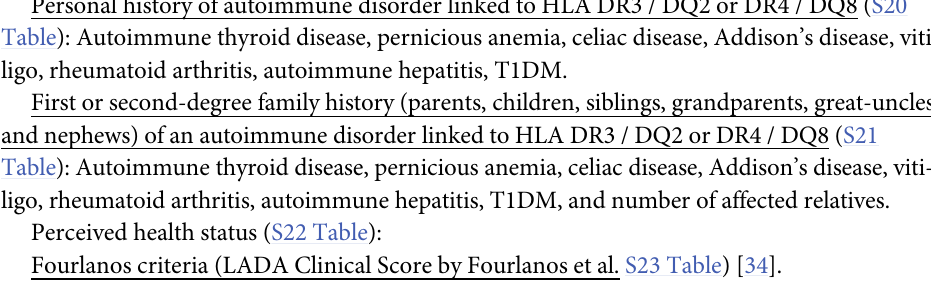
Table): Autoimmune thyroid disease, pernicious anemia, celiac disease, Addison’s disease, viti- ligo, rheumatoid arthritis, autoimmune hepatitis, T1DM. First or second-degree family history (parents, children, siblings, grandparents, great-uncles, and nephews) of an autoimmune disorder linked to HLA DR3 / DQ2 or DR4 / DQ8 (S21 Table): Autoimmune thyroid disease, pernicious anemia, celiac disease, Addison’s disease, viti- ligo, rheumatoid arthritis, autoimmune hepatitis, T1DM, and number of affected relatives. Perceived health status (S22